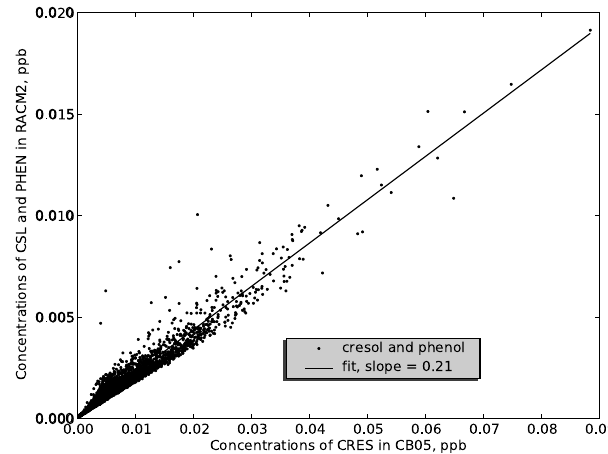
Fig. 4. Relation of concentrations of cresol between CB05 and RACM2 at each location. The concentration of phenol that is spec- ified only in RACM2 is added to the concentration of cresol for